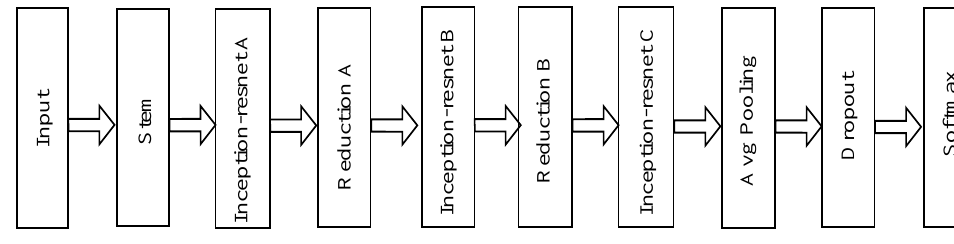
Figure 2. Basic block diagram of InceptionResNetV2